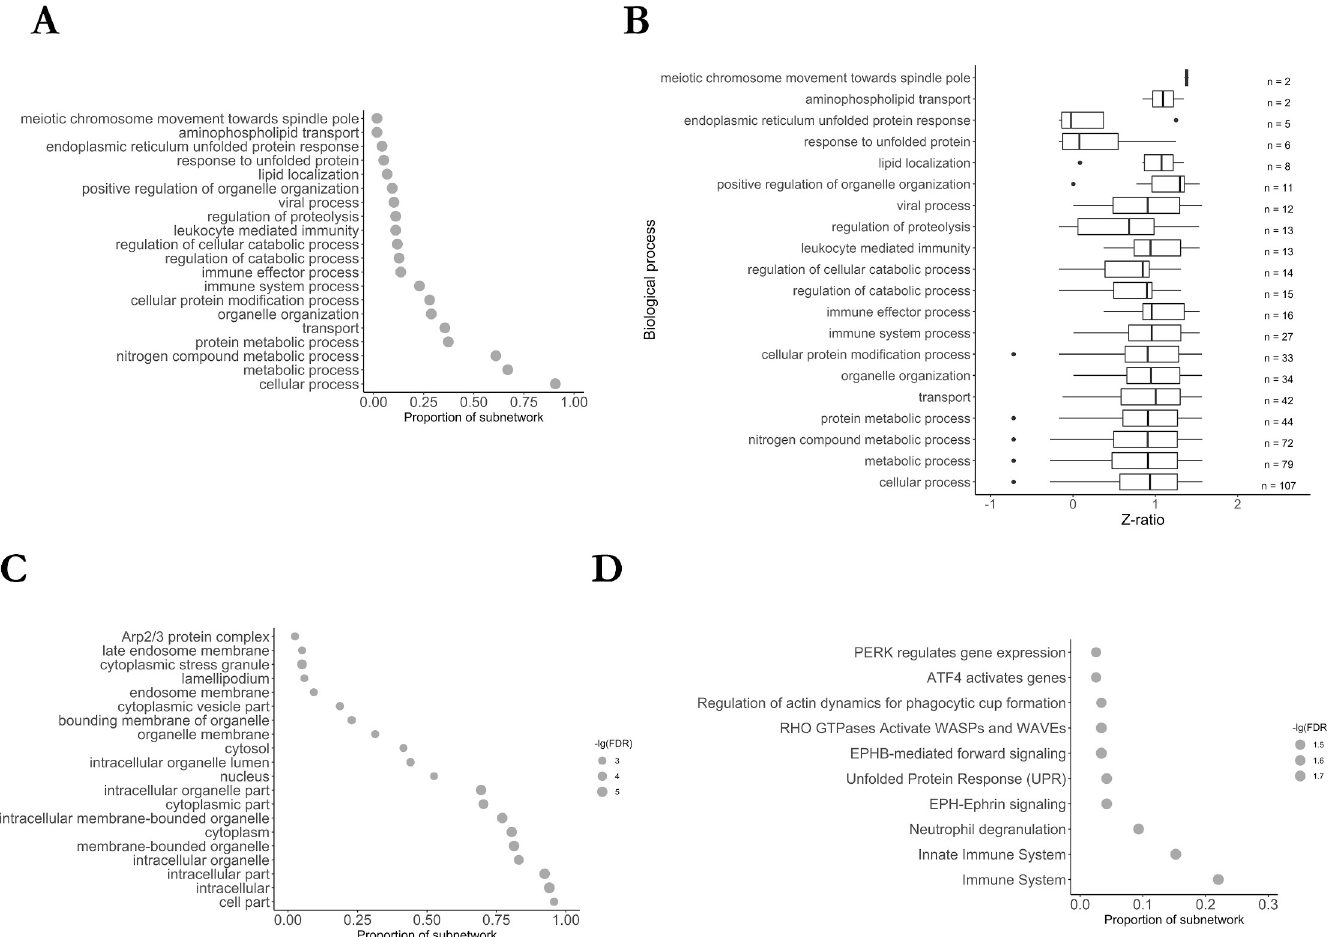
Fig 7. Enrichment analysis of MB meta-module. A: Gene ontology (GO) term enrichment analysis for biological processes. B: Mean z-ratios of genes belonging to the enriched biological processes. C: Gene ontology (GO) term enrichment analysis for cellular compartments. D: Enrichment of Reactome pathways.